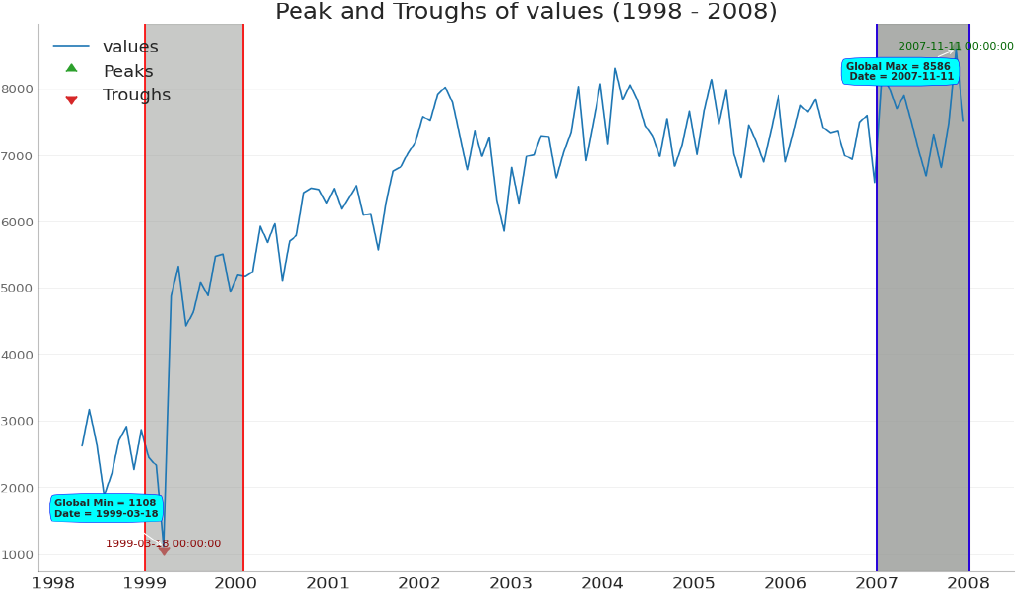
Figure 2. The time series plot of monthly crimes committed in KSA for the years 1990 to